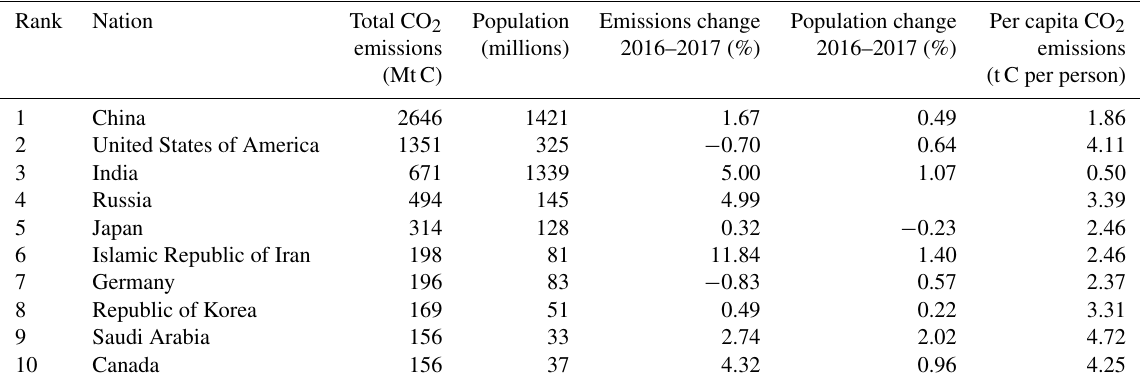
Figure 2. Total global CO 2 emissions from fossil fuel combustion and cement manufacture from 1950 to 2017, partitioned into fuel type, cement production, and gas flaring. Emissions are in gigatons of carbon. Table 2. Top 10 CO 2 -emitting countries with total CO 2 emissions in 2017, population in 2017, the changes in population and emissions from 2016 to 2017, and the 2017 per capita